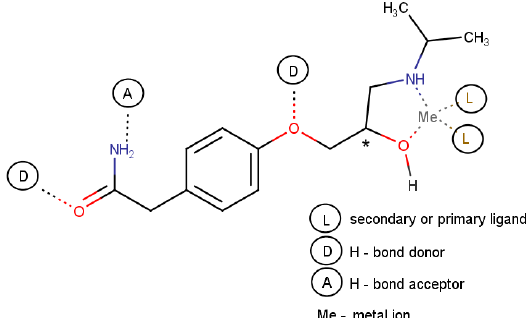
Figure 5. Potential interaction sites (coordinate and/or hydrogen bonding) of ATNL during non-covalent and MMMI.